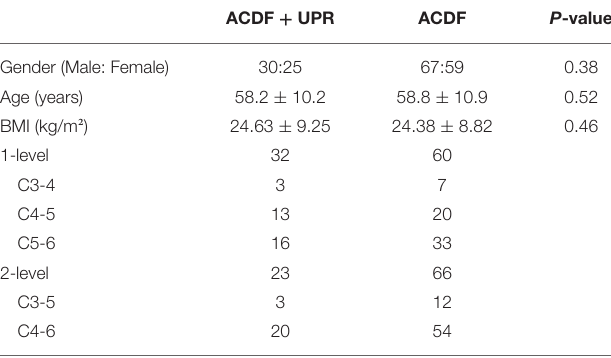
TABLE 1 | Comparison of study patient demographics.